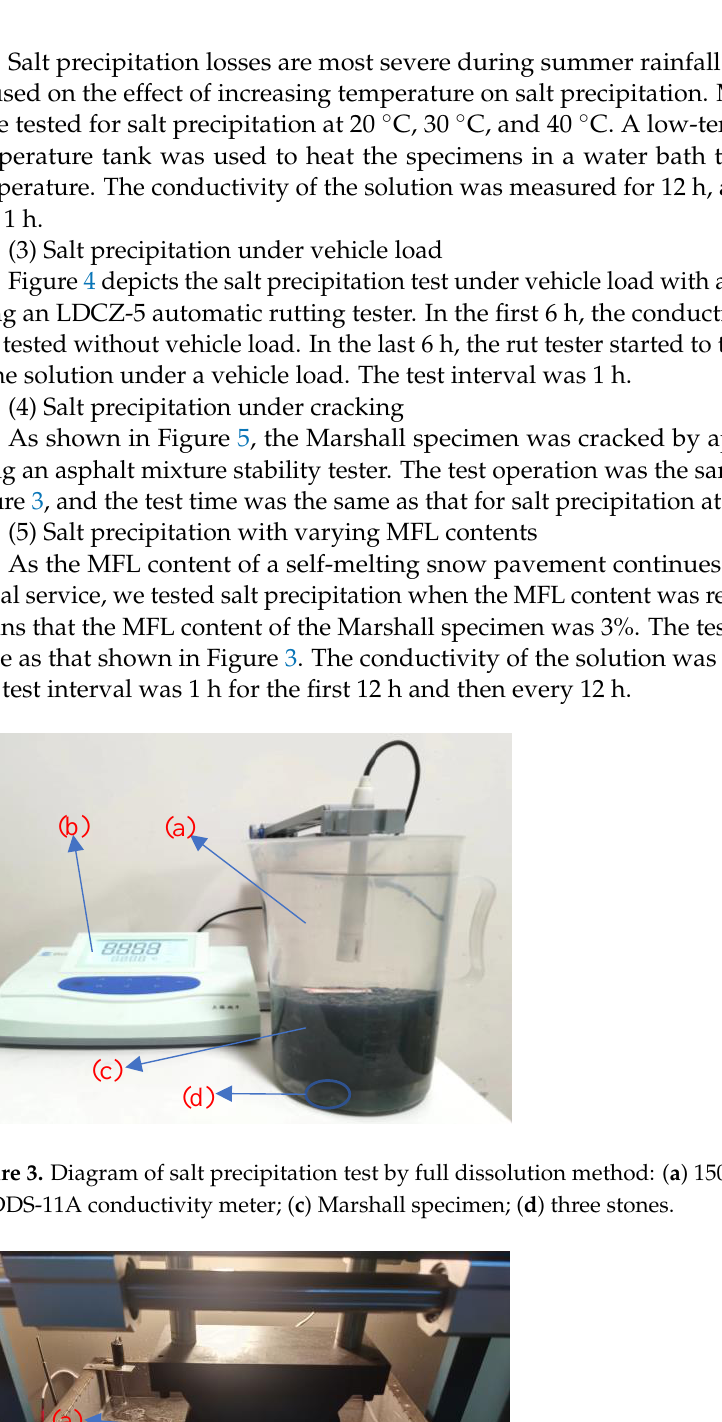
Figure 4. Diagram of salt precipitation test under vehicle load: ( a ) vehicle load; ( b ) rutting plate specimen; ( c ) 20 L drinking water.